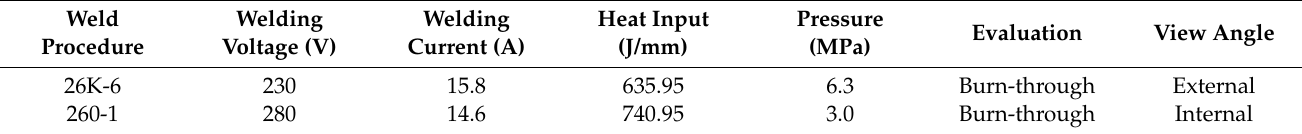
Table 6. Circumferential in-service welding